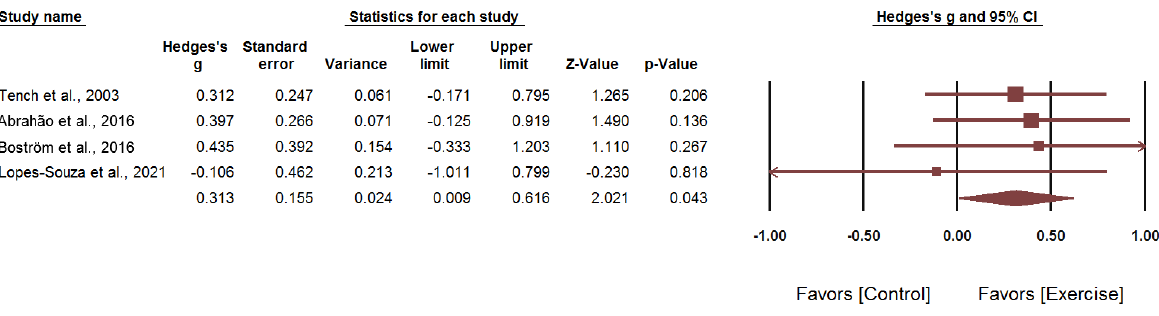
Figure 4. Forest plot of comparison with the outcome of the physical function domain of the SF-36.